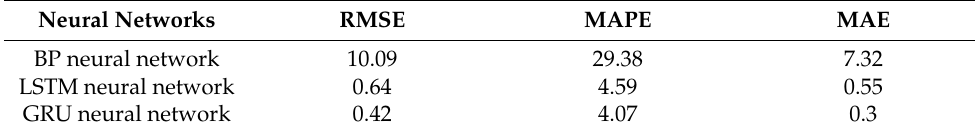
Table 6. Comparison of other network models.